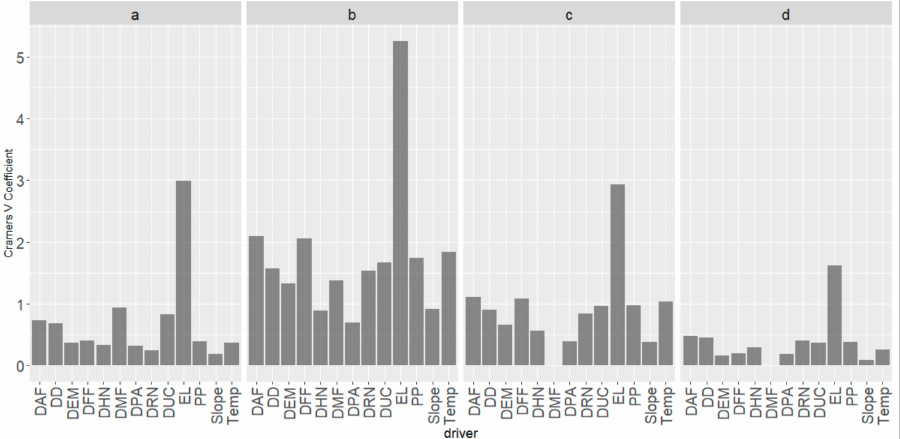
Figure 3. Main drivers influencing land use changes for each of the geographical zones: North ( a ), Central ( b ), Central South ( c ), and Austral ( d ). DAF: Distance to agricultural fields, DD: Distance to disturbances, DEM: Digital elevation model, DFF: Distance to forest fields, DHN: Distance to hydro- logical network, DMF: Distance to mining fields, DPA: Distance to protected areas, DRN: Distance to